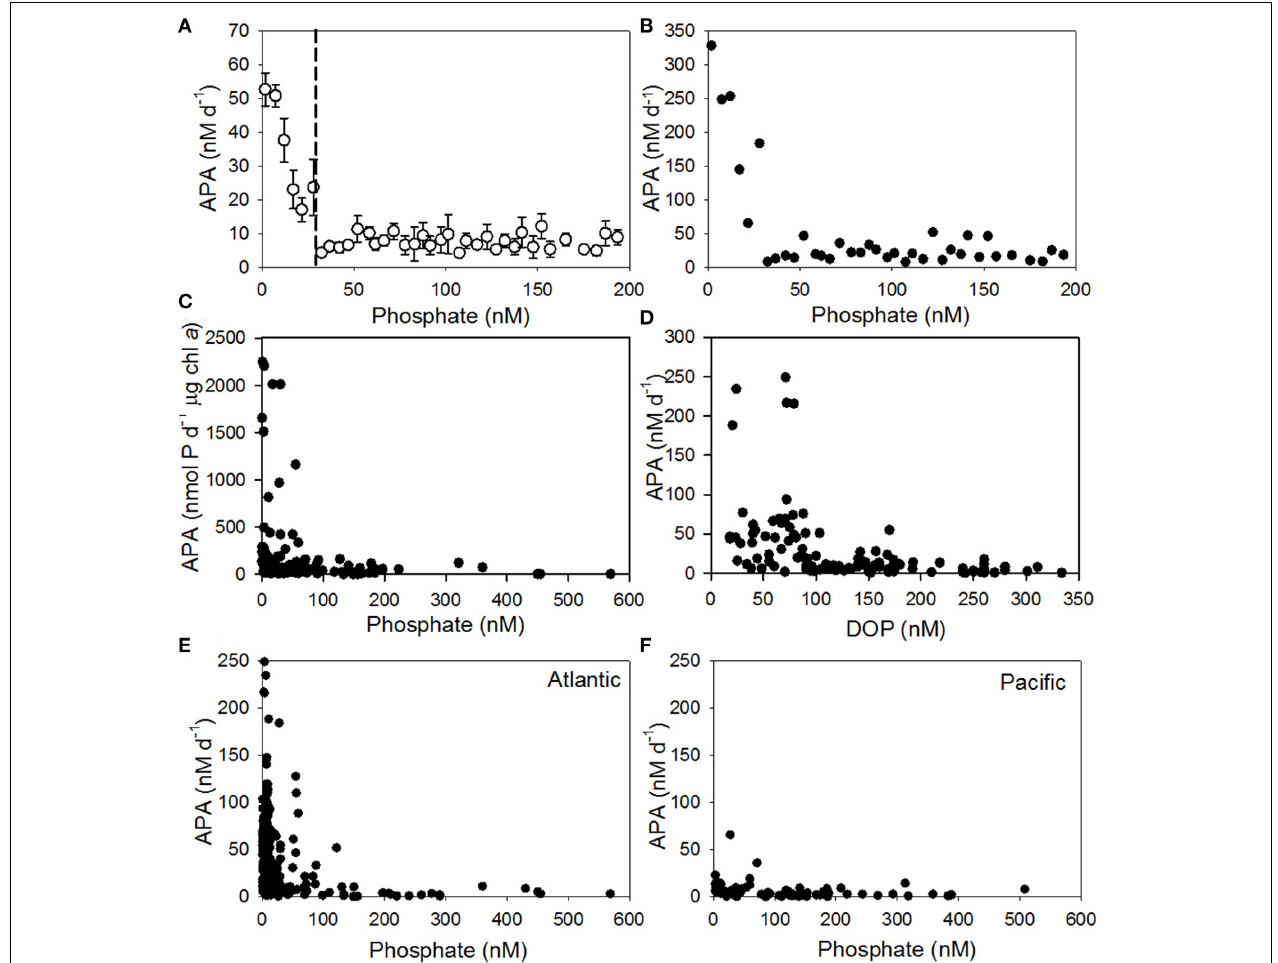
relativetophosphateconcentration(nM)and (D) ratesofAPA(nMd − 1 )relative to the concentration of dissolved organic phosphorus (DOP, nM) for surface waters only (0–20m) and (E) rate of APA (nM d − 1 ) relative to phosphate concentration (nM) for surface waters only (0–20m) for data collected from the Atlantic Ocean and (F) rate of APA (nM d − 1 ) relative to phosphate concentration (nM) for surface waters only (0–20m) for data collected from the Pacific Ocean. See Table 1 for details of studies included in this